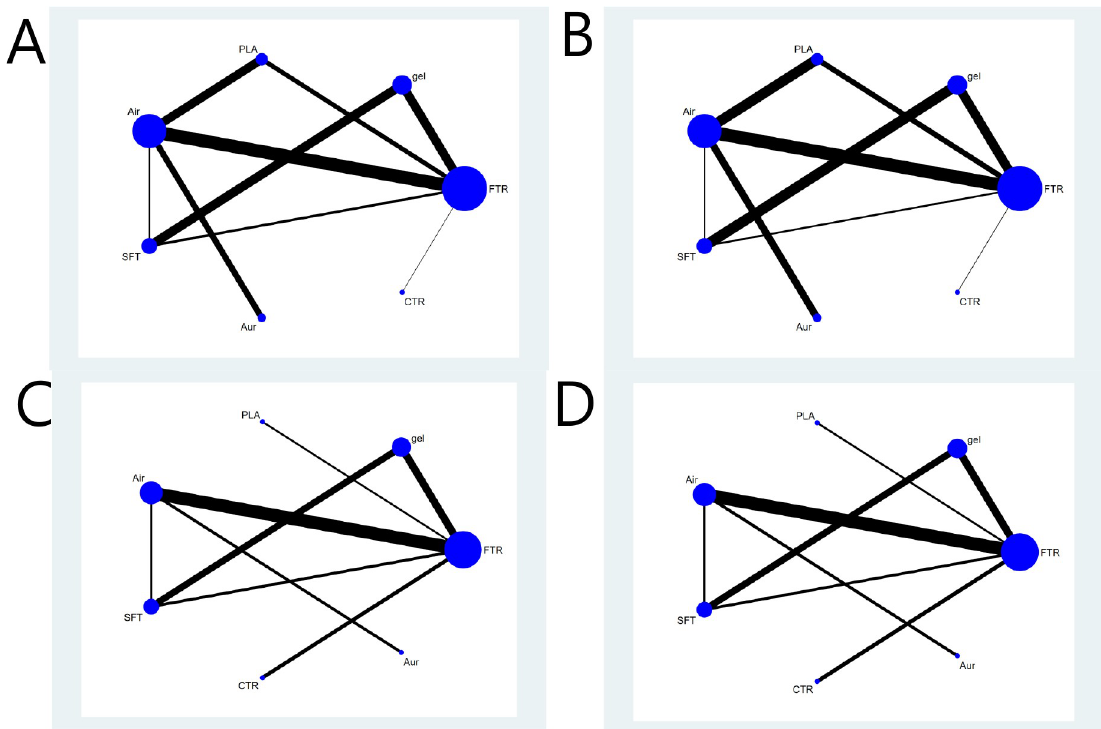
Fig 2. Network geometries. A network plot of direct comparisons for all included randomized controlled trials for the outcome of unassisted tracheal intubation. The width of the lines is proportional to the number of trials comparing each pair of treatments, and the size of every node is proportional to the number of randomized participants (sample size). A. The overall success rate of unassisted tracheal intubation by ITT; B. The overall success rate of unassisted tracheal intubation by PP; C. The success rate at first attempt by ITT; D. The success rate at first attempt by PP. ITT, intention to treat; PP, per protocol. SFT = single-use LMA-Fastrach; PLA = CobraPLA; Air = Air- Q; FTR = LMA-Fastrach; gel = i-gel; Aur = Ambu-Aura; CTR =